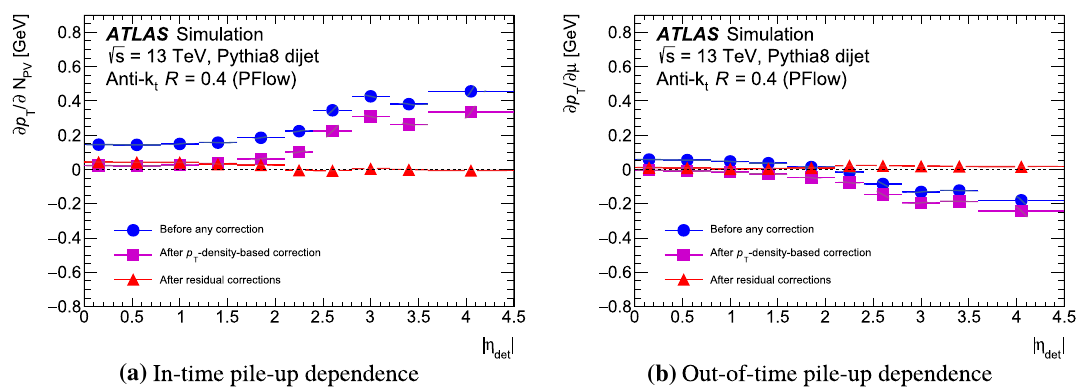
Fig. 4 Dependence of PFlow jet p T on a in-time pile-up ( N PV averaged over μ ) and b out-of-time pile-up ( μ averaged over N PV ) as a function = 25GeV. Errors are taken from the fit results and are too small to be visible on the scale of the plot of | η det | for p true T